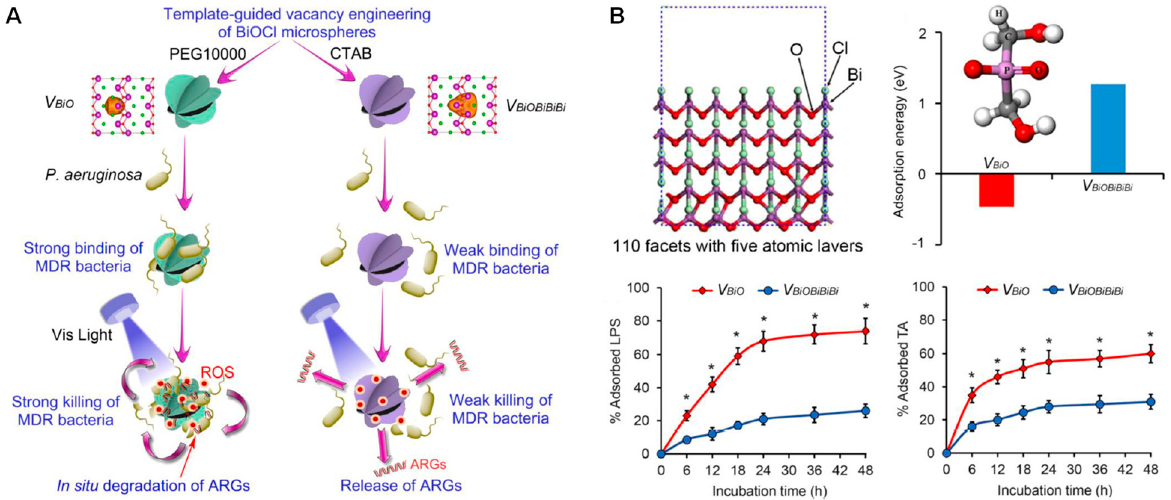
Figure 6. ( A ) Scheme of vacancy engineering of BiOCl microspheres for binding and killing bacteria; ( B ) Adsorption ability of the BiOCl microspheres to bacterial cell wall components LPS and TA via first − principles computations and experiments. * indicates significant difference between the two groups at the indicated time point ( p < 0.05). Reproduced with permission from Ref. [ 103], 2021, Elsevier.